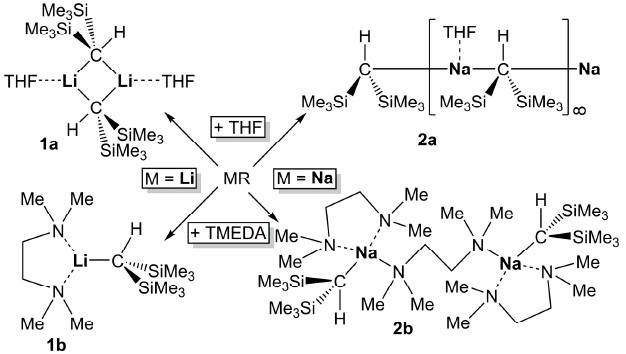
Scheme 2. Formation of compounds 1a , b and 2a , b by adding THF or TMEDA to solutions of the corresponding compounds 1 or 2 in n -hexane.